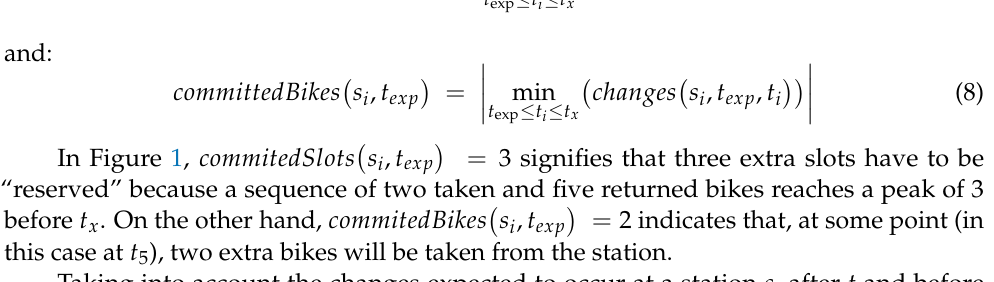
, 𝑡 (cid:3439) , and 𝑐𝑜𝑚𝑚𝑖𝑡𝑒𝑑𝑆𝑙𝑜𝑡𝑠(cid:3435)𝑠 (cid:3036) (cid:3032)(cid:3051)(cid:3043)